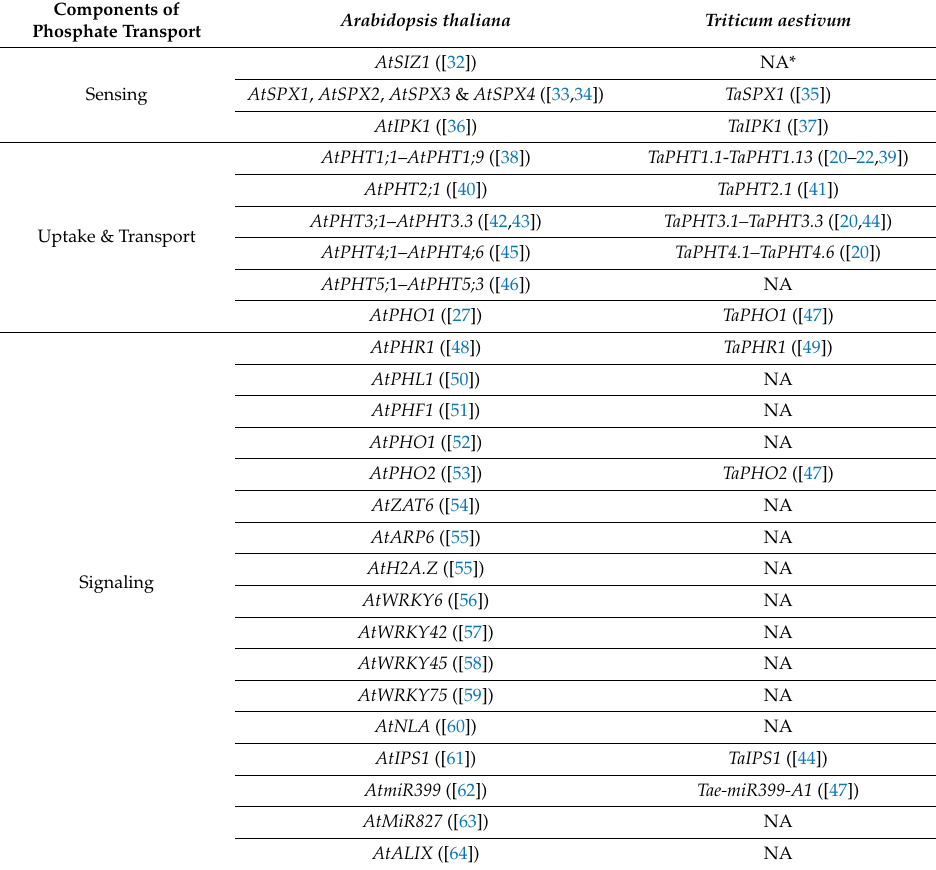
Table 1. Inventory for the list of genes and regulators those are involved in sensing, uptake and signaling during Pi limiting conditions in model plant Arabidopsis and Triticum aestivum